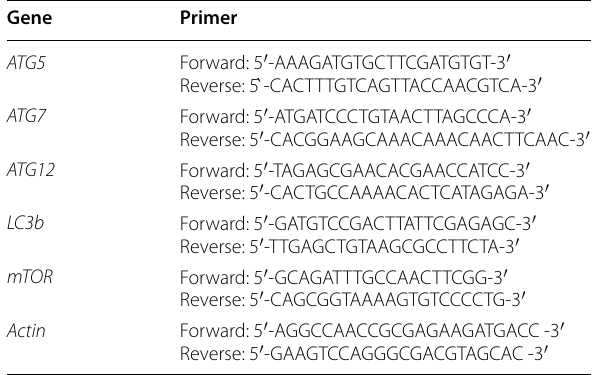
Table 1 Primer sequences for the selected studied autophagy genes and housekeeping